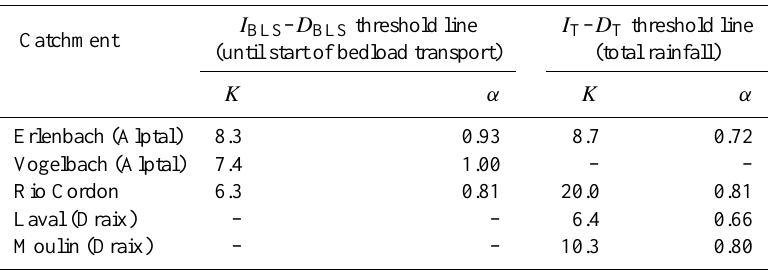
Table 4. Defined intensity–duration threshold lines: values for the prefactor K and exponent α in the equation ( I BLS = K D − α